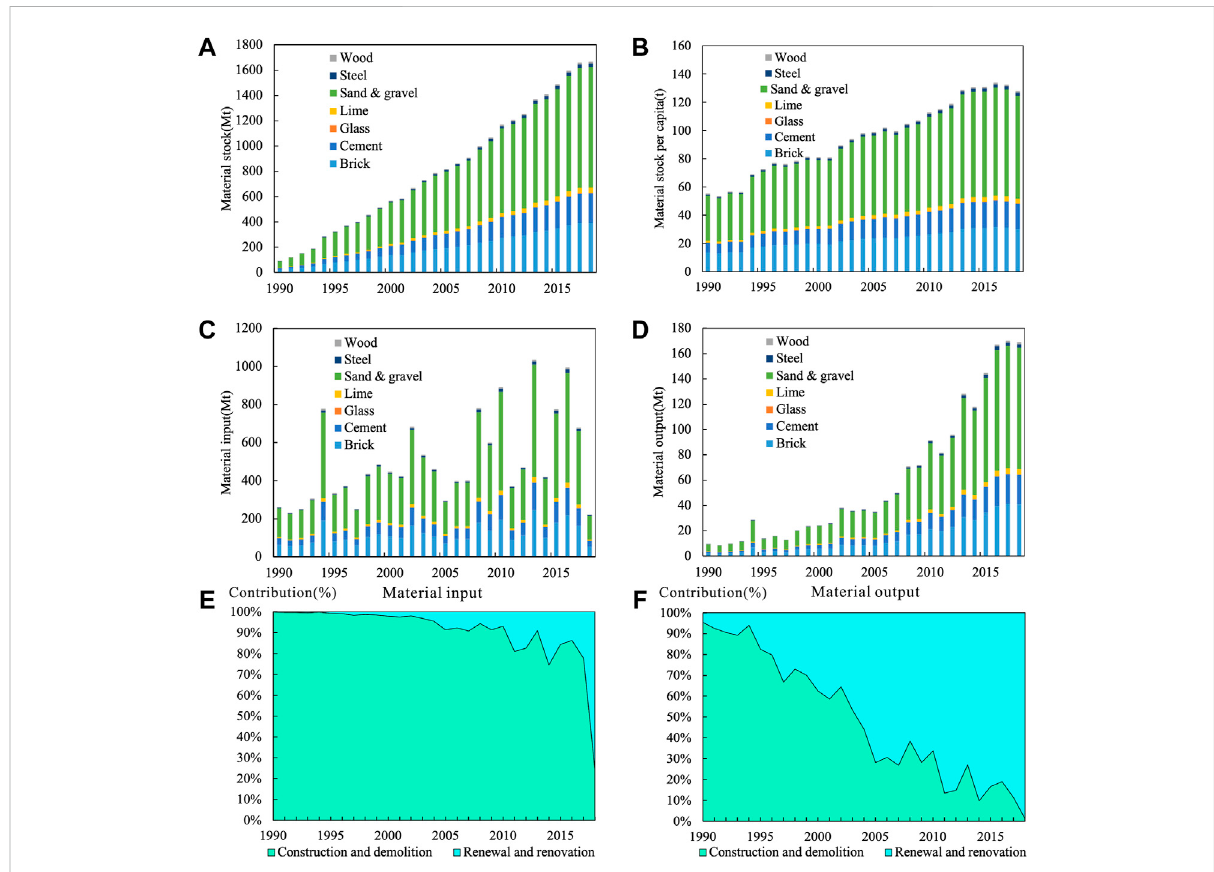
FIGURE 7 MaterialmetabolismofbuildingsinShenzhen,China(1990 – 2018). (A) showsthetotalmaterialstockinShenzhenfrom1990to2018; (B) shows the material stock per capita in Shenzhen from 1990 to 2018; (C,D) show the material in fl ow and out fl ow in Shenzhen from 1990 to 2018, respectively; (E,F) offer the proportion of in fl ow and out fl ow generated from urban construction and renewal activities during 1990 – 2018,